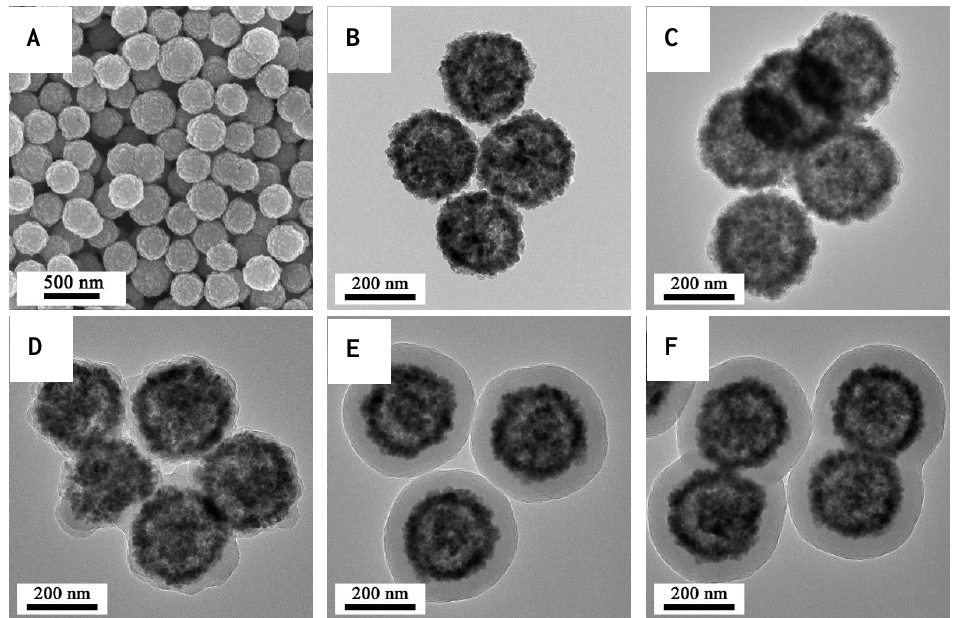
Figure 1. SEM ( A ) and TEM ( B ) images of hollow Fe 3 O 4 ; TEM images of Fe 3 O 4 @RF microspheres with different shell thicknesses: Fe 3 O 4 @RF-4 ( C ), Fe 3 O 4 @RF-6 ( D ), Fe 3 O 4 @RF-10 ( E ) and Fe 3 O 4 @RF-4 ( F ). The inset in Figure 1A is the statistical result of the particle size.